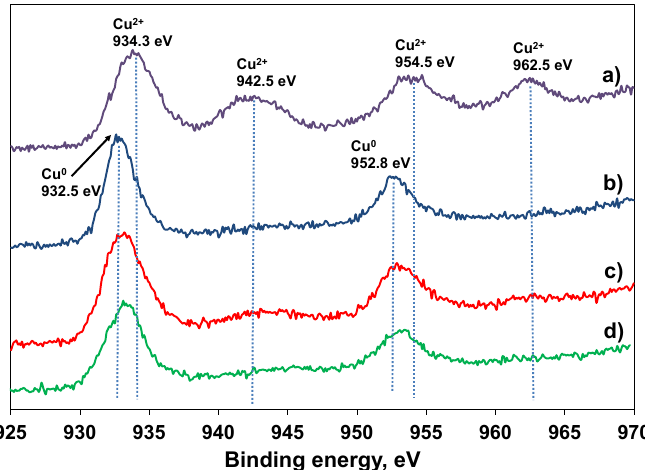
Figure 5. X-ray photoelectron spectroscopy (XPS) spectra of Cu 2p for 2Pd-CZA catalysts: ( a ) unreduced fresh catalyst; ( b ) reduced fresh catalyst; ( c ) unreduced spent catalyst; ( d ) reduced spent catalyst. CZA: Cu/Zn/Al (molar) = 35/35/30. All traces have been displaced for clarity.